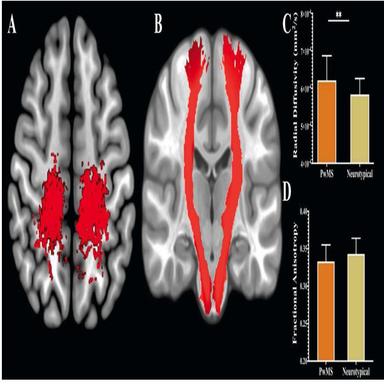
Diminished sensorimotor pathway microstructural integrity in PwMS. (A) Axial and (B) coronal views of the ICBM-152-based atlas achieved from template suite in ExploreDTI (University Medical Center Utrecht, Netherlands, Version 4.8.6; (http://www.exploredti.com)). (C) PwMS demonstrated significantly greater radial diffusivity (0.62e -3 (0.66e -4)) of the sensorimotor pathway white matter fiber tracts compared to neurotypical adults (0.58e -3 (0.42e -4)). Data are mean (± SD); \\ significant group difference